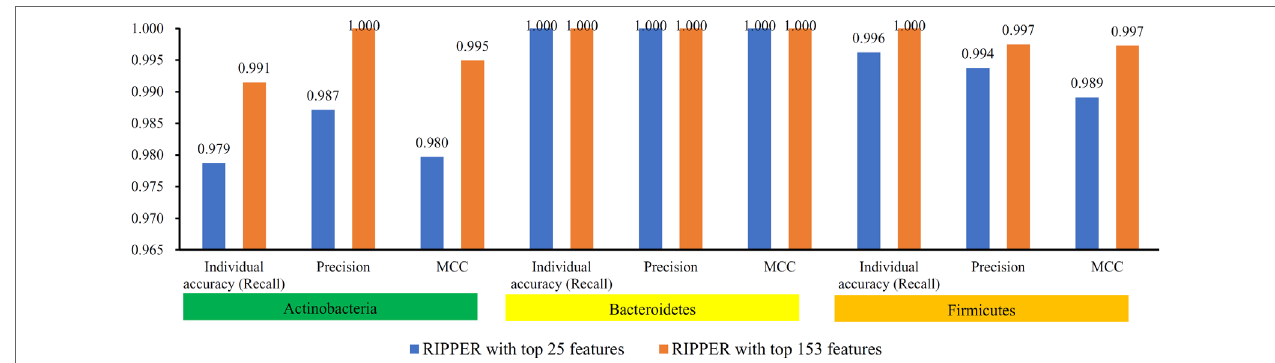
FIgURe 3 | Performance of RIPPER algorithm with top 25 and 153 features on each phylum. The RIPPER algorithm with top 153 features provided nearly perfect classification, while the RIPPER algorithm yielded a little lower performance.